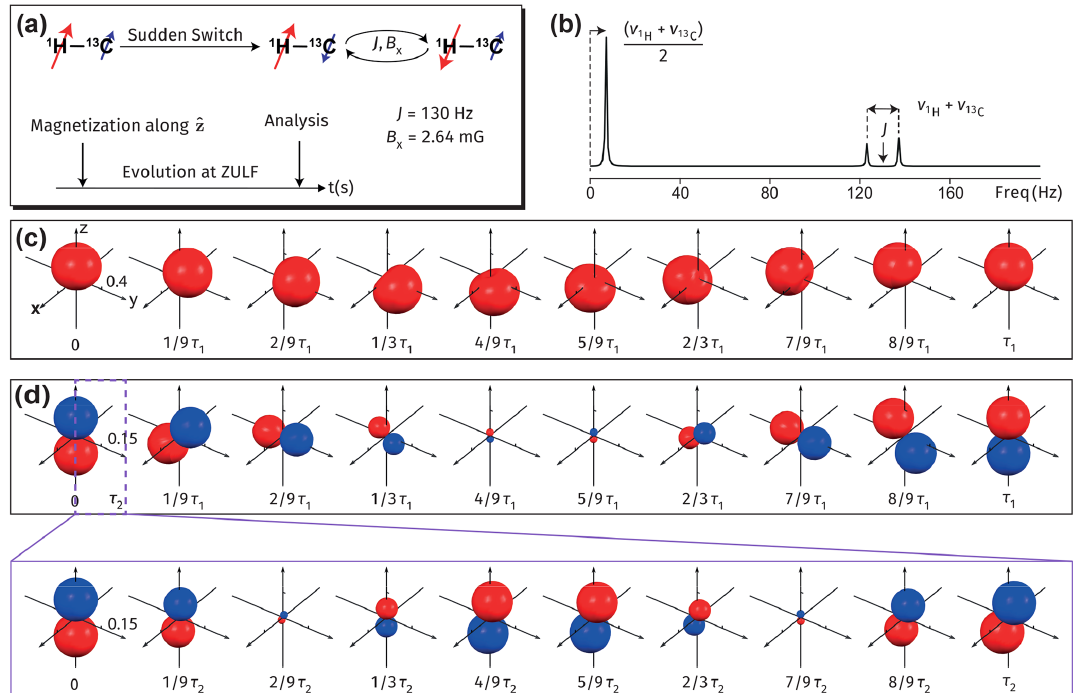
Figure 5. Visualizations of spin dynamics in an AX system ( 1 H– 13 C nuclear pair) during the zero- to ultralow-field nuclear magnetic resonance (ZULF NMR) experiment. (a) Scheme of an exemplary ZULF NMR experiment in which a perpendicular field of 2.64mG is applied during the detection. (b) Simulation of the corresponding ZULF NMR spectrum. Assume the initial density operator of the system is ˆ I ˆ I 13 C and 1 H nuclei, respectively). Panels (c) – (d) show surfaces representing spin evolution ˆ ρ = (1 / 4) 1 + (1 / 10)( ˆ I + 4 ˆ I 0 1 z 2 z ) ( 1 and 2 denote in the ZULF experiment plotted with the measurements (c) ( | 1 , 1 (cid:105)(cid:104) 1 , 1 | ) ˆ n over a timescale τ 1 = 1 /ν = 2 / ( ν 1 over a timescale τ 1 (inset) shows the evolution of the surfaces plotted in panel (d) over a shorter timescale τ 2 = 1 /J